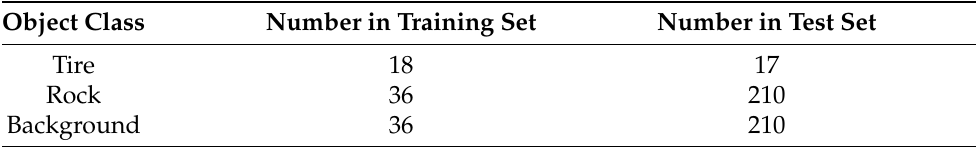
Table 5. Labeled classes for the classification task and division into training and test sets.